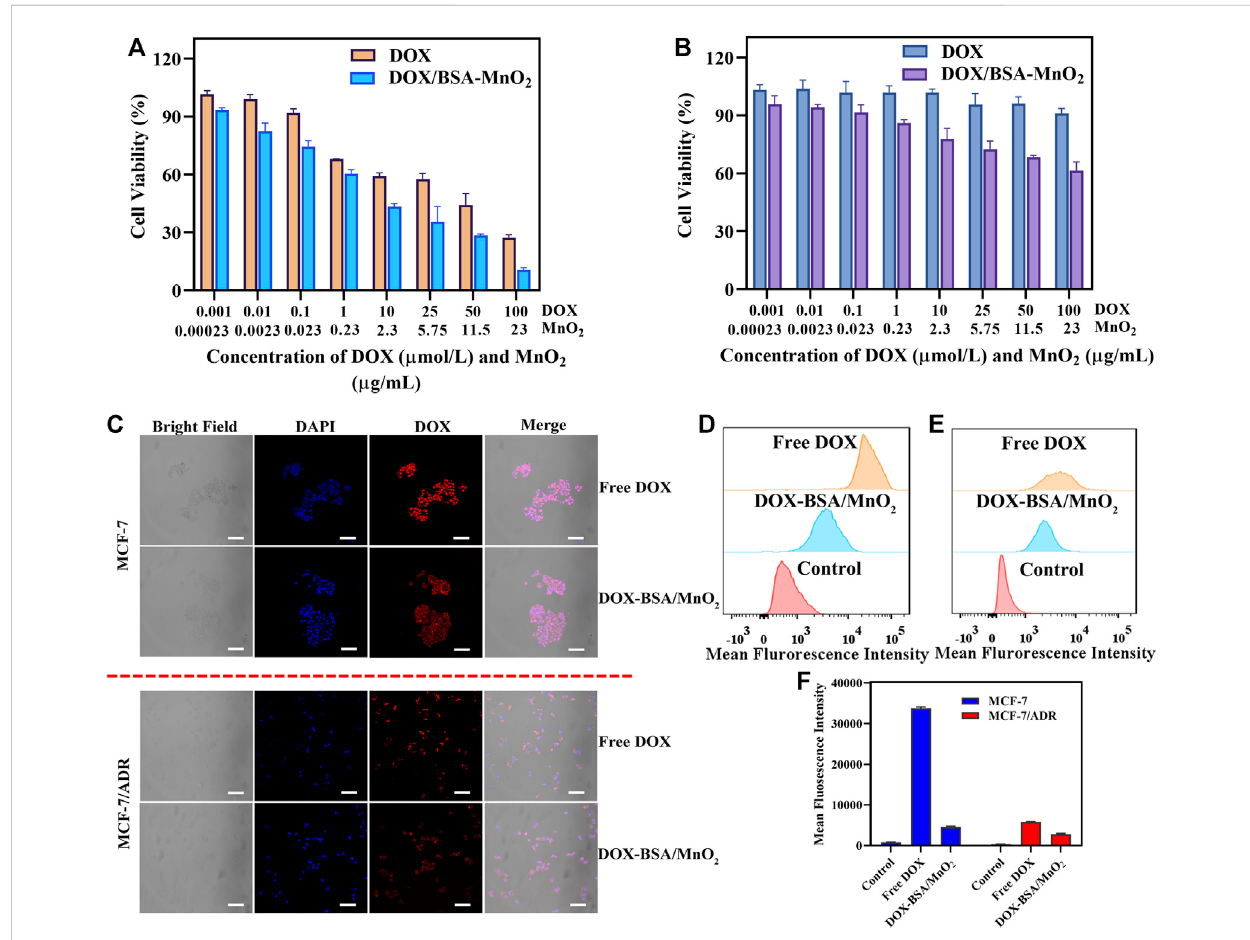
FIGURE 2 Invitro cellularexperiments.Thecellviabilityof (A) MCF-7cellsaswellas; (B) MCF-7/ADRcellssubjectedtoDOXalongwithDOX-BSA/MnO severaldoses;n=5; (C) cellularuptakeoffreeDOXbesidesDOX-BSA/MnO 2 NPsbyMCF-7togetherwithMCF-7/ADRcellsafterincubationfor6h;scale bar = 100 μ m; (B) overlay of fl uorescence intensity data obtained through fl ow cytometer of (D) MCF-7 cells as well as; (E) MCF-7/ADR cells incubated with DOX along with DOX-BSA/MnO 2 NPs for 6 h; (C) mean fl uorescence intensity of MCF-7 cells besides MCF-7/ADR cell lines incubated with DOX-BSA/MnO 2 NPs for 6 h; n =